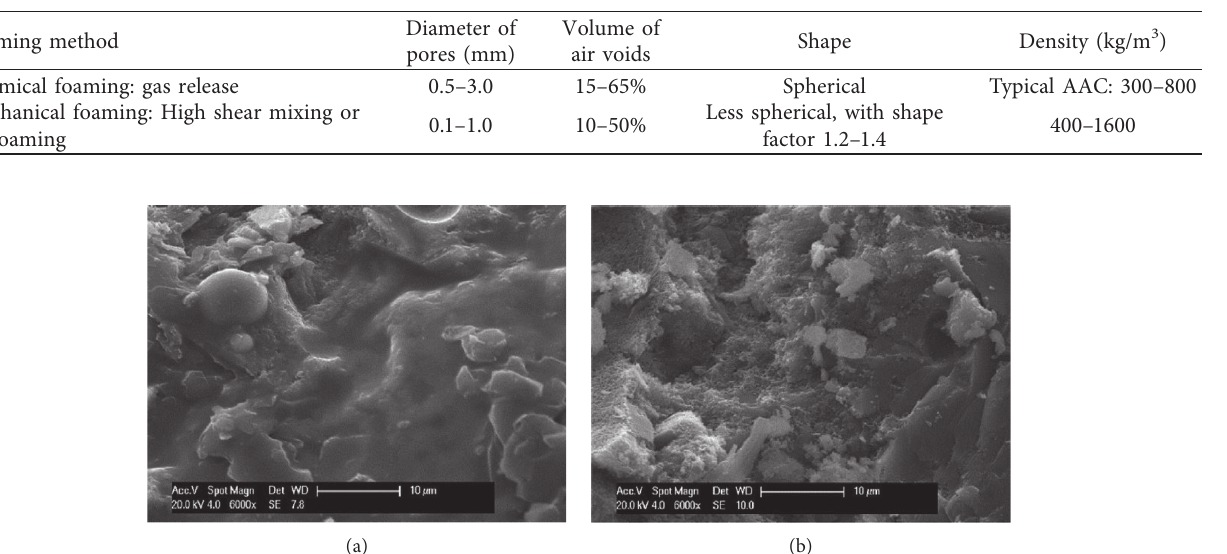
Figure 2: Effect of additives on cement paste microstructure, (a) with additive (more homogeneous) and (b) without additive